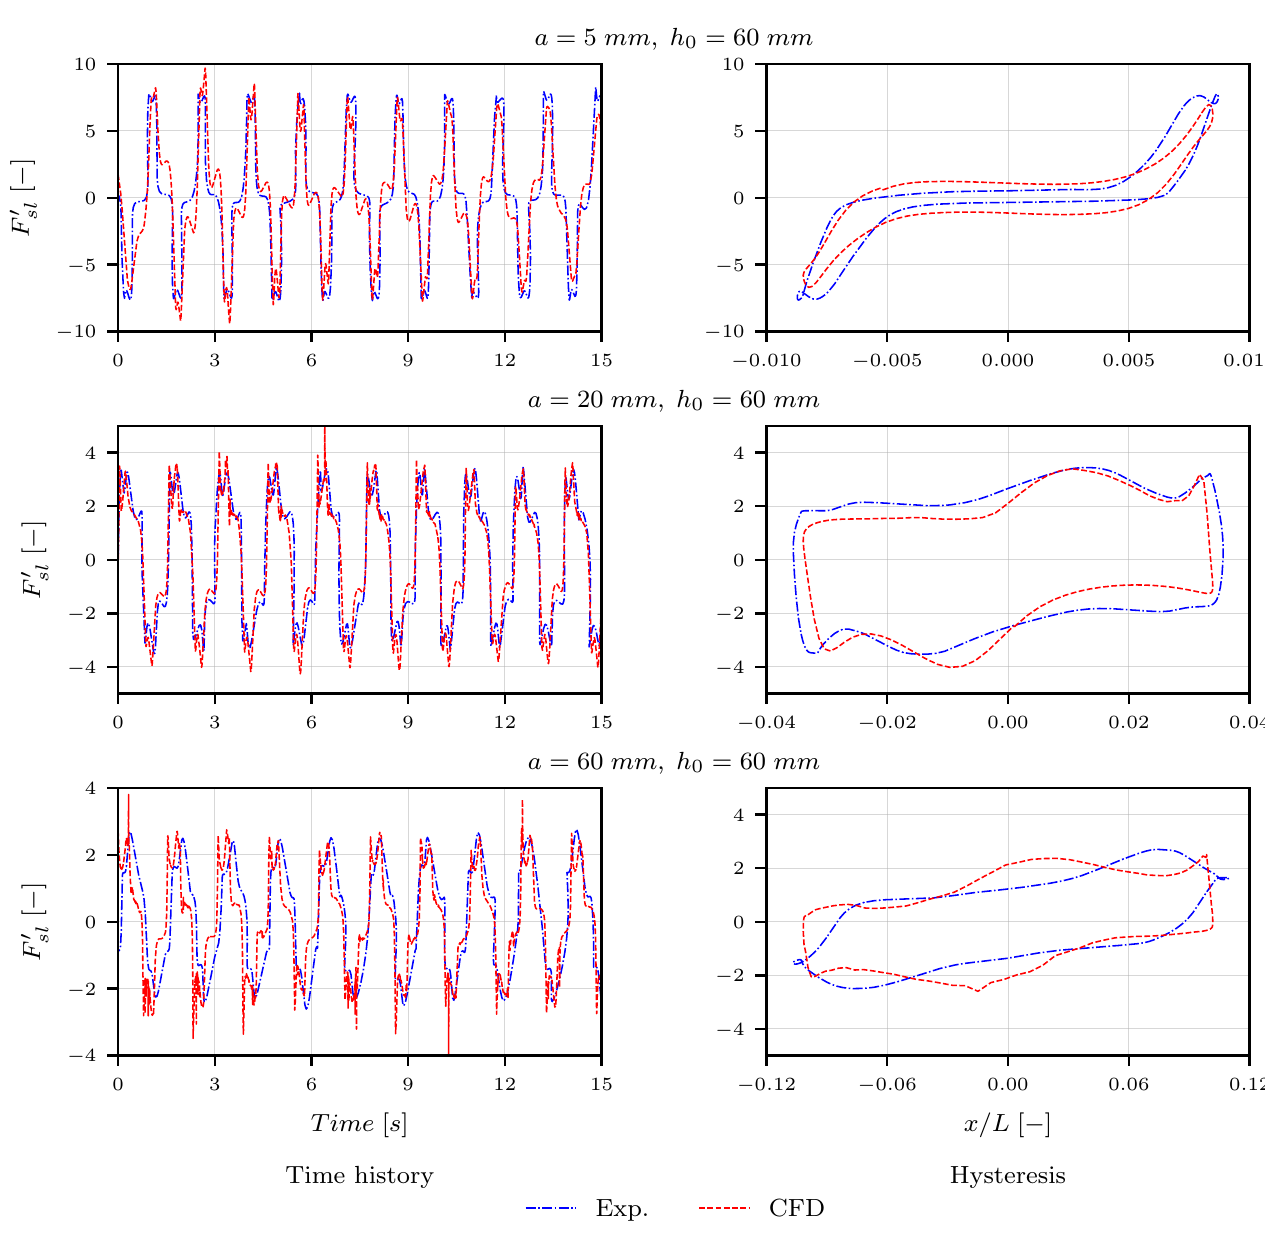
Figure 4. Validation results for varying the amplitude of excitation. Table 1. Dimensionless energy per hysteresis